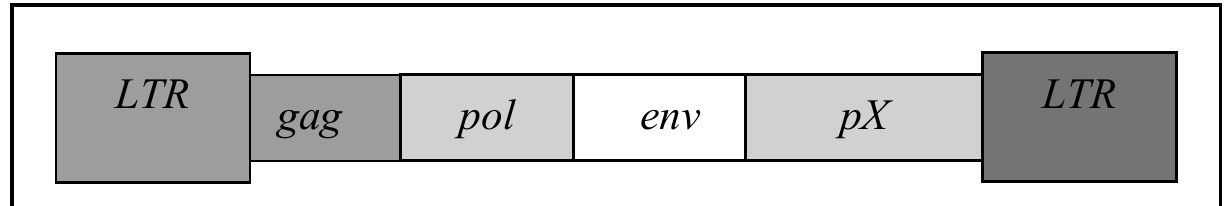
Figura 2 – Diagrama de quocientes, segundo Reiber e Felgenhauer, 1987. Quociente limite – 0 mg/l de síntese local de anticorpo. A síntese local para valores acima da linha limite é avaliada em mg/l. A linha pontilhada apresenta os valores IgG (log) em % da concentração de IgG no LCR. 1. normal; 2. disfunção da barreira hemato-LCR; 3. síntese intratecal de IgG + disfunção da barreira hemato-LCR; 4. síntese intratecal de IgG IgG: imunoglobulina da classe G; LCR: líquido